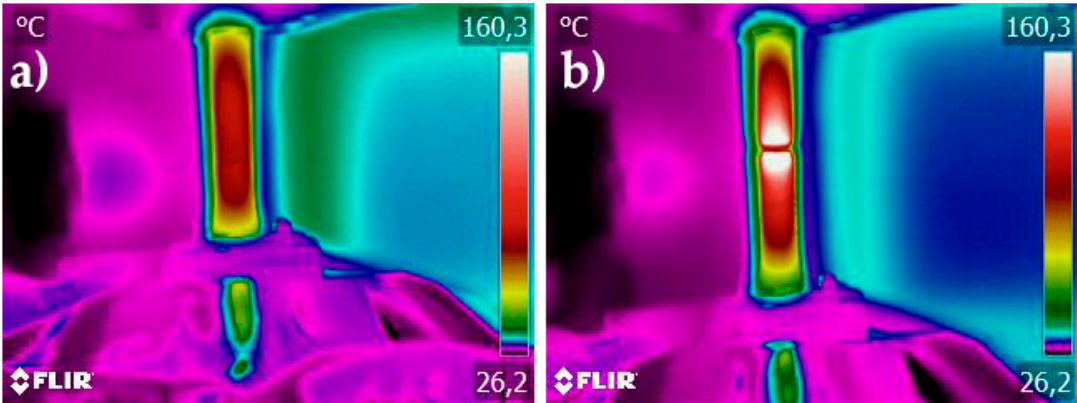
Figure 4. Thermal images of UNS S32101: ( a ) before the tensile test; and ( b ) immediately after fracture. The tensile test was conducted at 5 A/mm 2 .